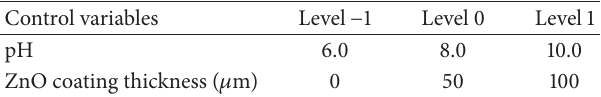
Table 1: Variables and levels based on the Surface response methodology (15 runs with replication) for the dairy wastewater photocatalytic